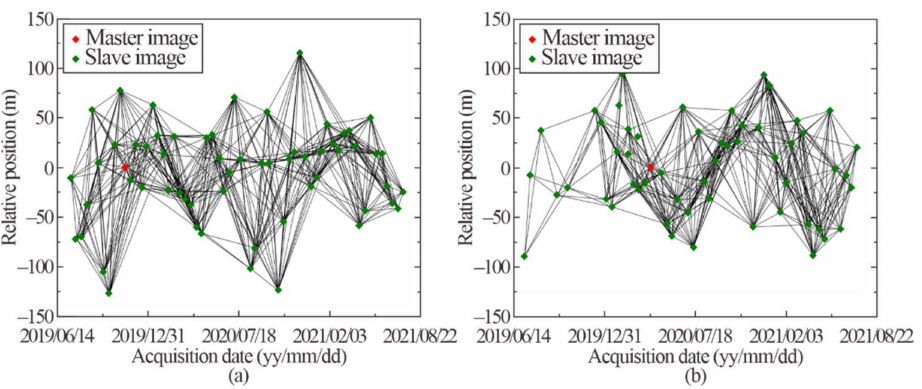
Figure 5. Generated interferometric combinations of the two datasets: ( a ) Ascending Sentinel-1A dataset; ( b ) Descending Sentinel-1A